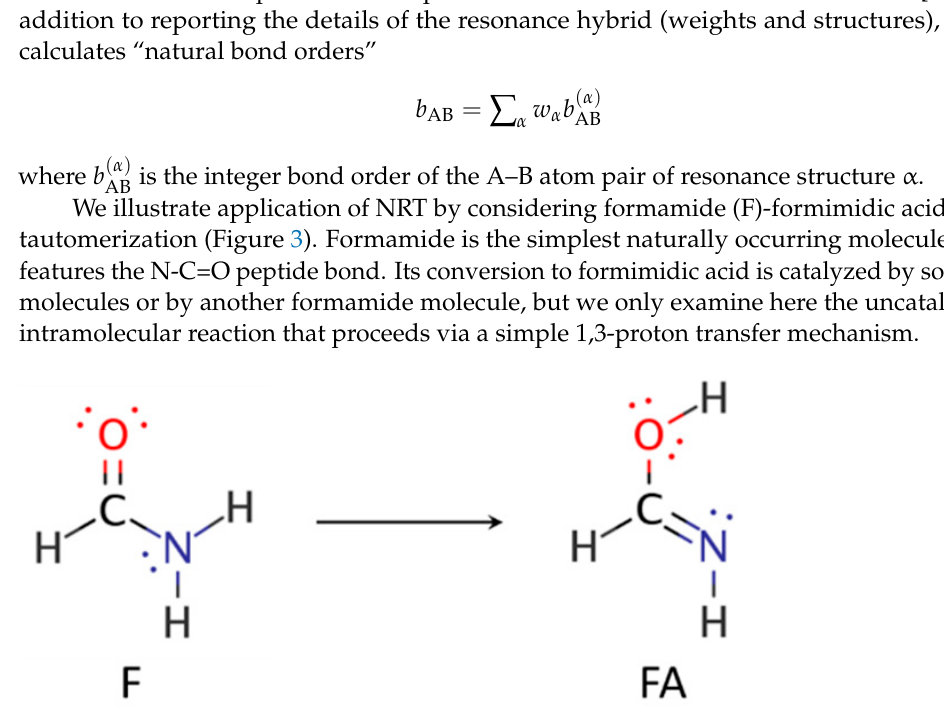
Figure 3. Schematic bonding patterns for tautomeric isomerization of formamide (F) to formimidic acid (FA).